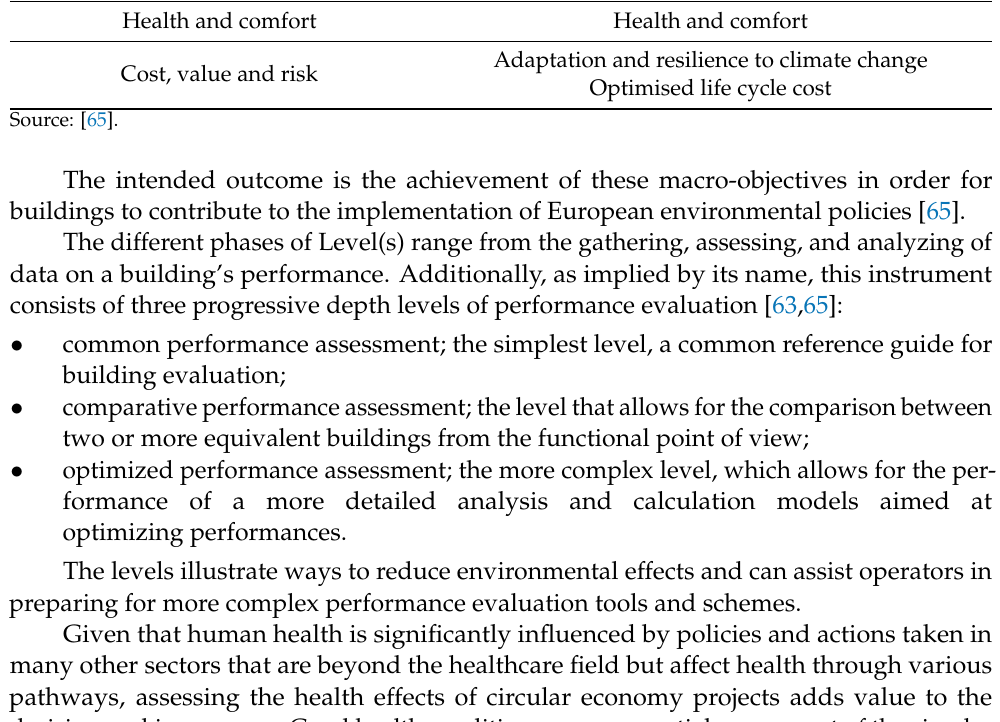
Table 1. Thematic areas and macro-objectives of the Level(s) tool. Thematic Areas Macro-Objectives Greenhouse gas emissions along a building life cycle Environmental performances Resource efficient and circular material life cycle of life cycle Efficient use of water resources Health and comfort Health and comfort Adaptation and resilience to climate change Cost, value and risk Optimised life cycle cost Source: